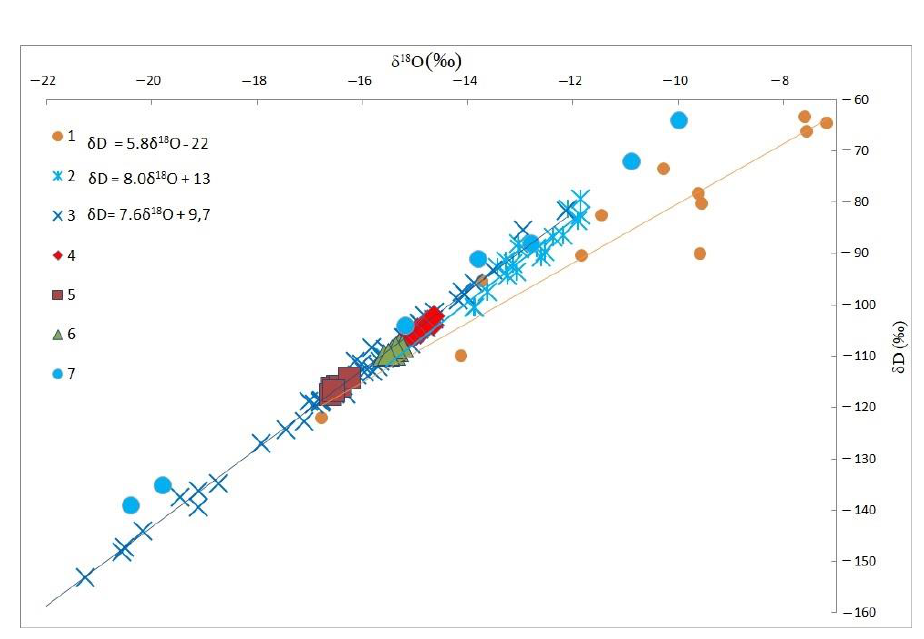
Figure 5. Relationship between δ 18 O and δ D for the main groups of samples. 1—Precipitation, 2—Snow and firn, 3—Ice, 4—Water from hydrological station No. 1, 5—Water from hydrological station No. 2, 6—Stream from glacier No. 9, Model values of the isotopic composition of precipitation on ELA (number-month number)